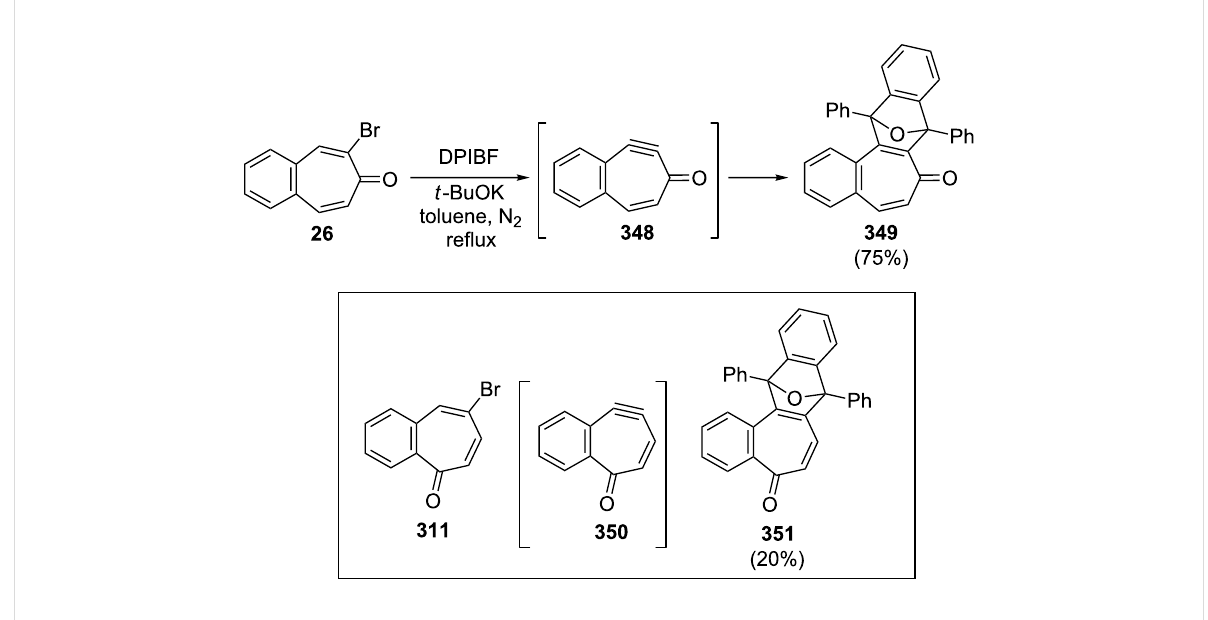
Scheme 62: Reactions of bromobenzotropones 26 and 312 with t -BuOK in the presence of DPIBF.